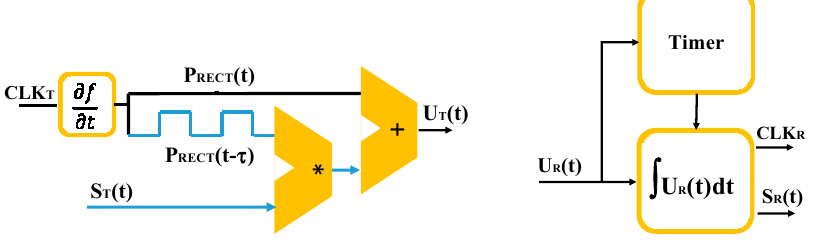
Figure 3. Description, at logic block level, of the implementation of the coding (on the left ); and decoding (on the right ) systems.